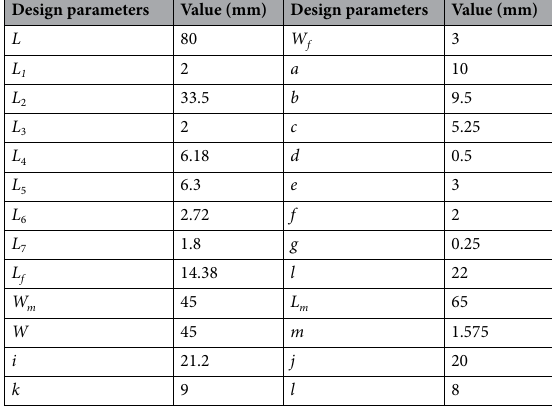
Table 1. Optimized design dimension of the finalized antenna.